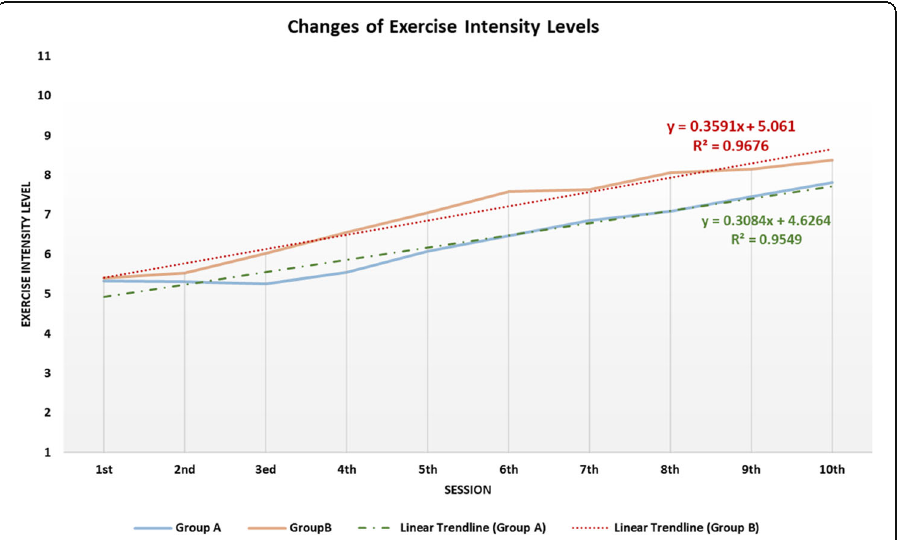
Fig. 14 Changes of exercise intensity